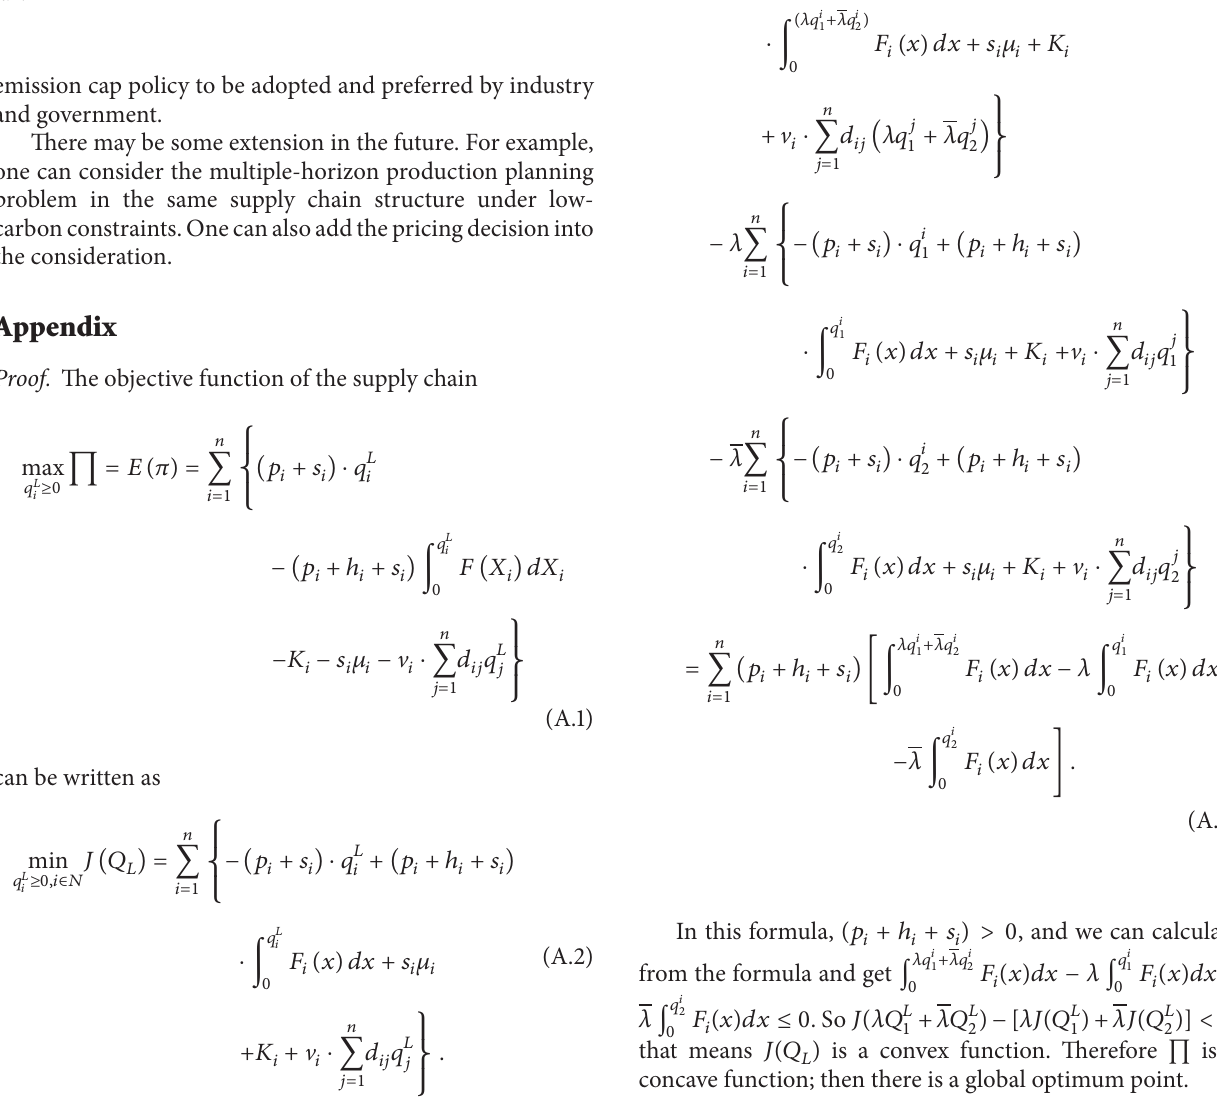
Figure8:Carbonemissionelasticityofprofitunderdifferentcarbon